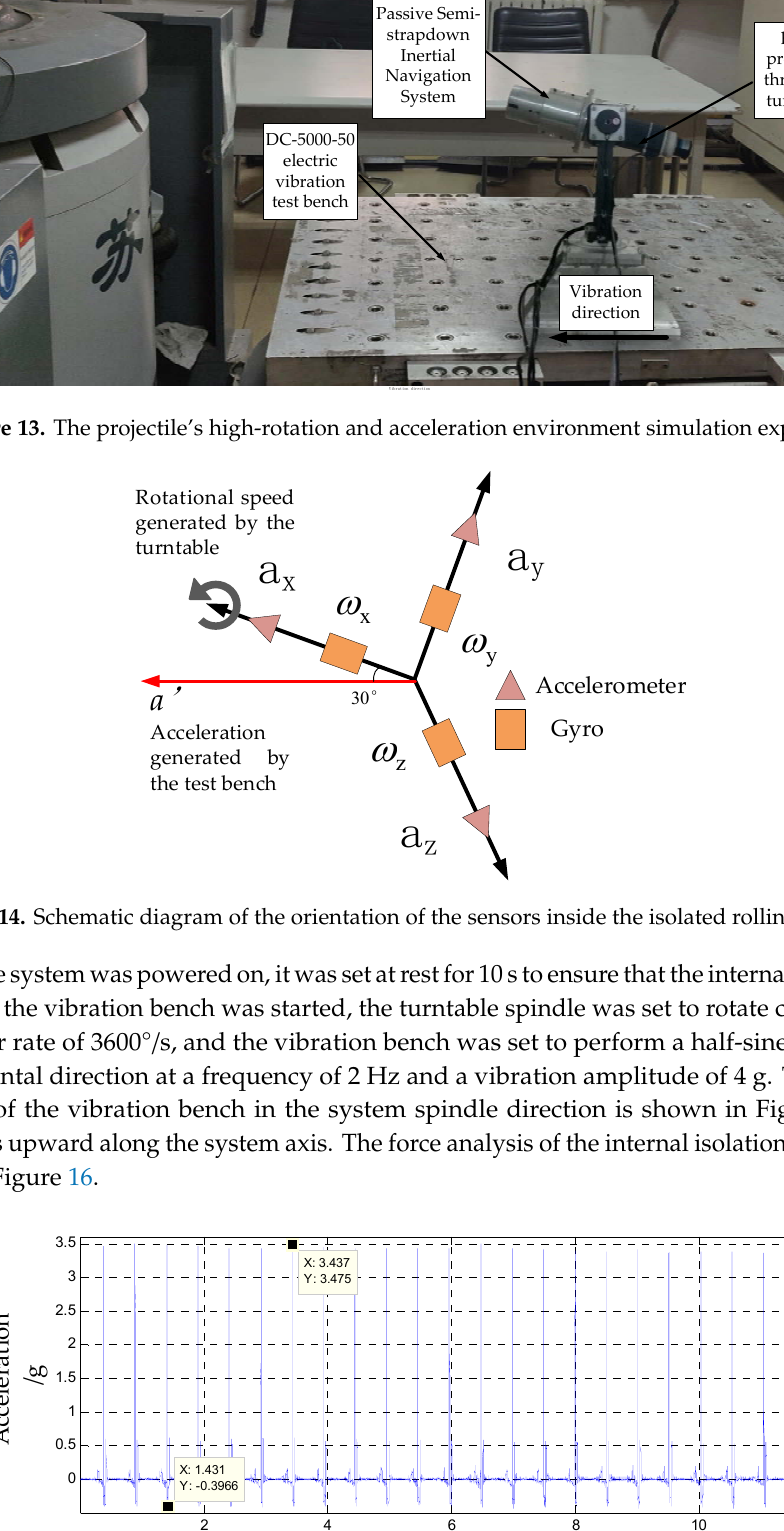
Figure 16. Force analysis of the isolation rolling platform. By assuming that the support force Fn of the isolation rolling platform is upward along the system axis, Equation (9) can be obtained: